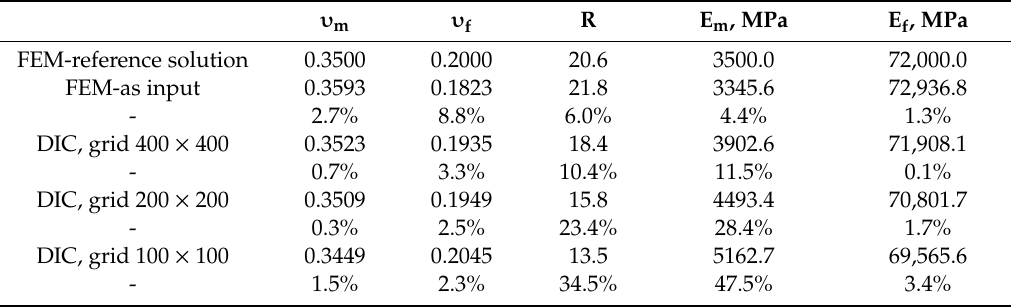
Table 5. Results of the Identification of Constituents Properties for Material 1.